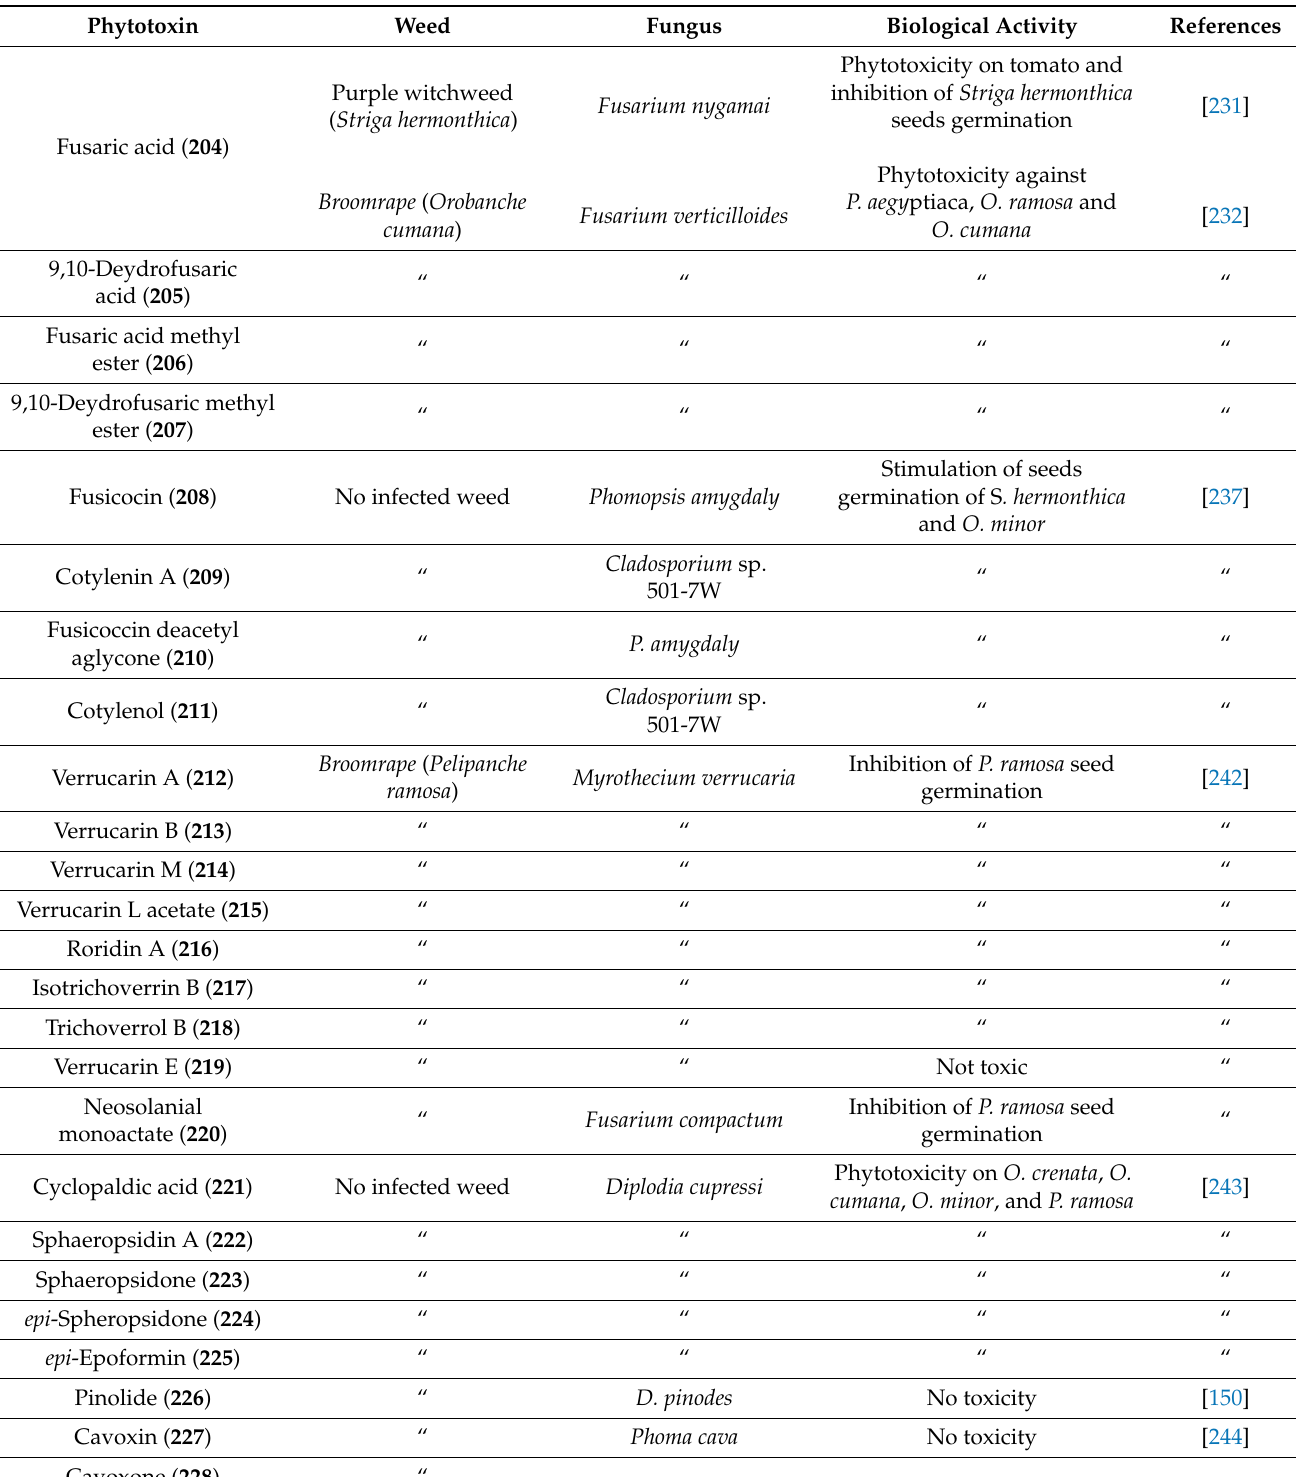
Table 3. Microbial phytotoxins to biocontrol parasitic